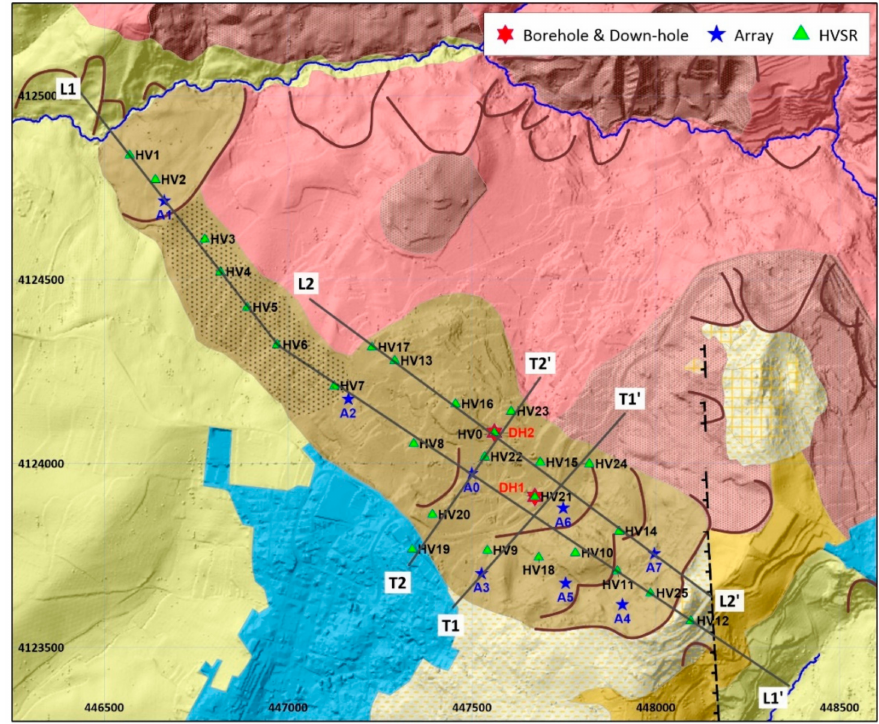
Figure 3. Location of sites of measurement in the Guëv é jar landslide area. The colors and signatures are the same as in Figure